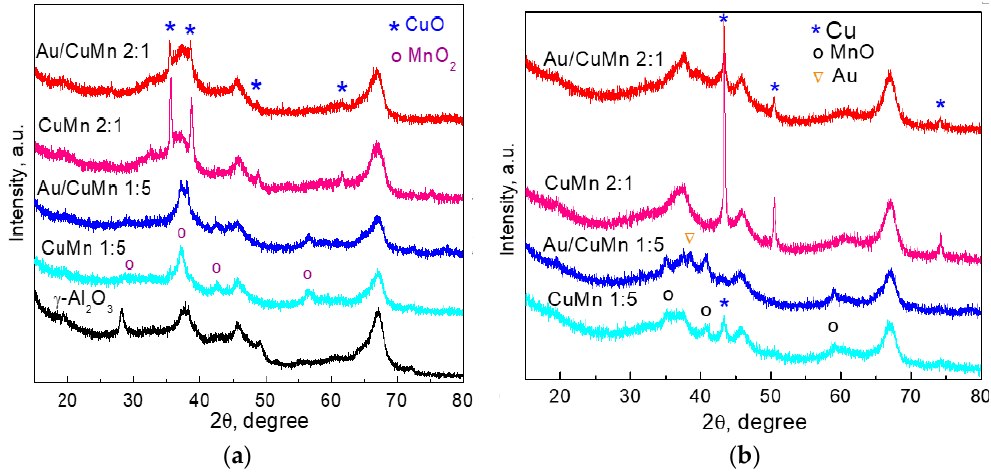
Figure 2. The powder X-ray diffraction (XRD) patterns of fresh ( a ) and WGS-tested ( b ) samples. Analysis of the XRD patterns of the samples tested in the WGS reaction (Figure 2b) revealed significant phase changes. Sharp reflections at 2 θ = 43.3, 50.4, and 74.1° indicated that during the reaction the separate phase of CuO in the Cu-rich samples was reduced to Cu 0 , while MnO 2 in the samples with a Cu-to-Mn ratio of 1:5 was reduced to MnO (peaks at 2 θ = 34.9, 40.6, and 58.7°). It was